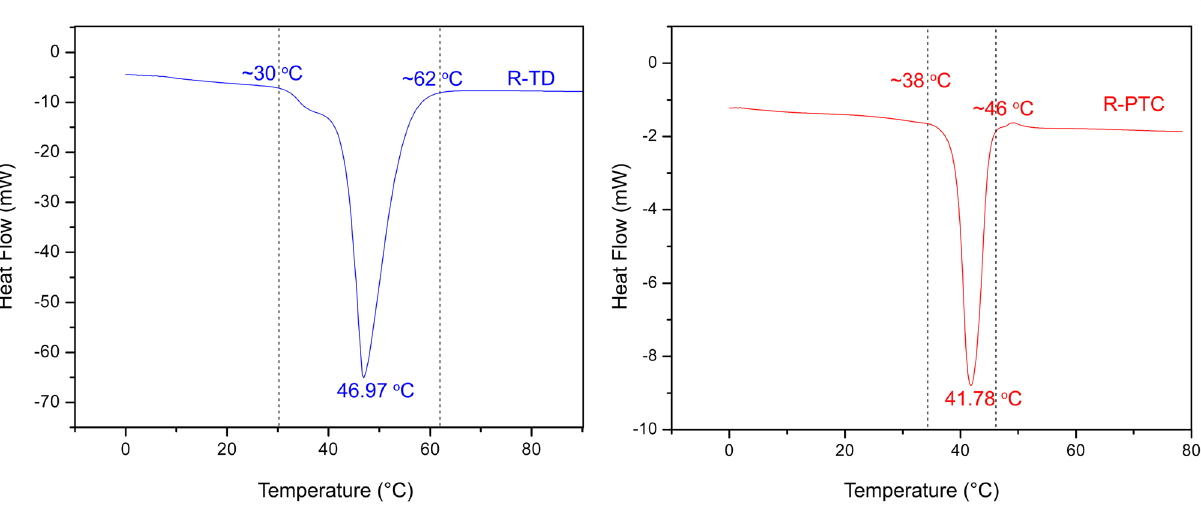
Figure 4. The DSC curve of R-TD and